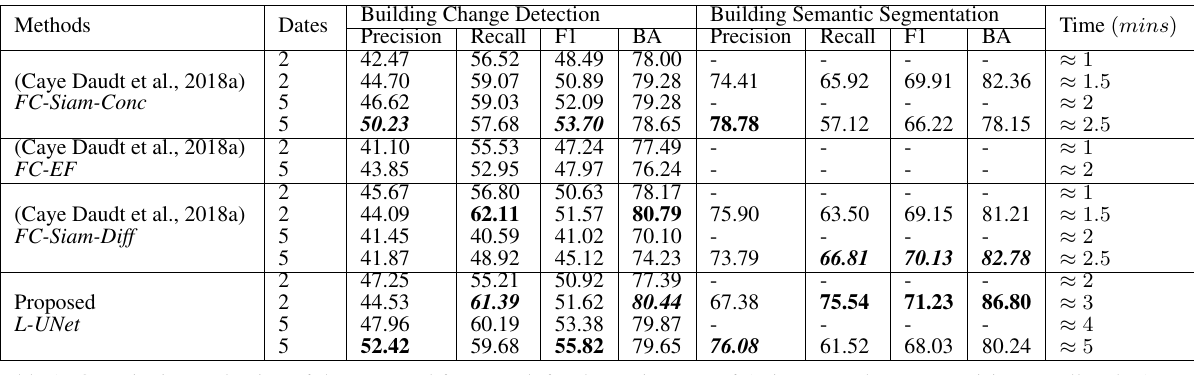
Table 1. Quantitative evaluation of the proposed framework for the testing part of Attica VHR dataset. Precision, recall and F1 rates are associated to the building change class as well as the building class for the image of 2006, while Balanced Accuracy (BA) is also provided. All the rows demonstrate results using the RGB-NIR bands with the last column indicating the computational time needed for each method to complete one training epoch. With bold we indicate the best performance and with bold and italic the second best performance per evalaution